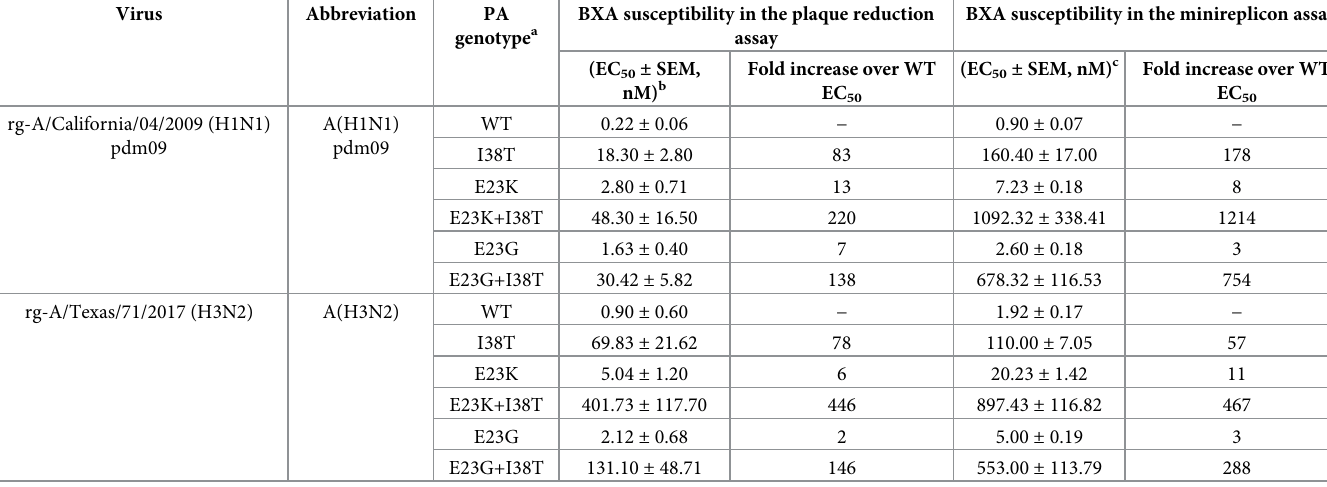
Table 1. Influenza A(H1N1)pdm09 and A(H3N2) viruses used in this study and their susceptibility to BXA.